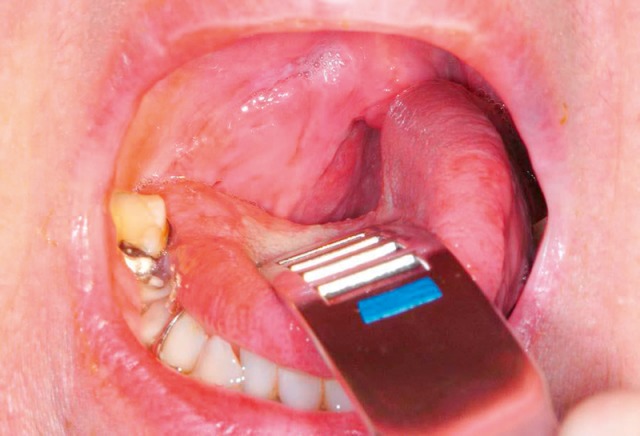
69-year-old female patient with right-sided parapharyngeal neurofibromas and increasing dysphagia. Uvula displacement to the left side. Impaired swallowing in the oropharyngeal phase.